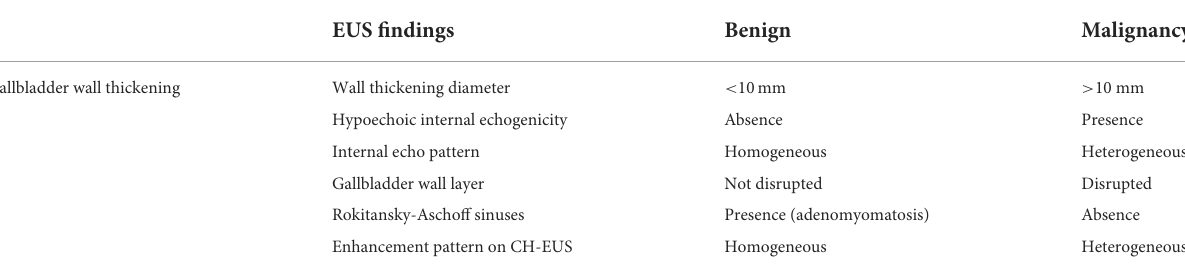
TABLE 4 Characteristic findings of gallbladder wall thickening in FB-EUS and